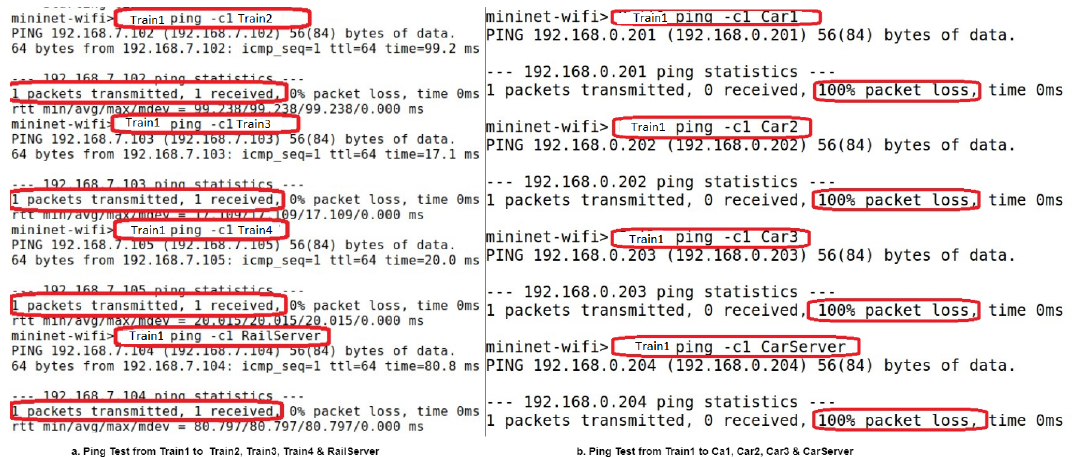
Figure 19. Reachability test for